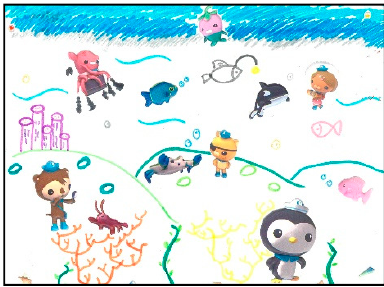
Figure 2. An unsuccessful case of using different painting materials.